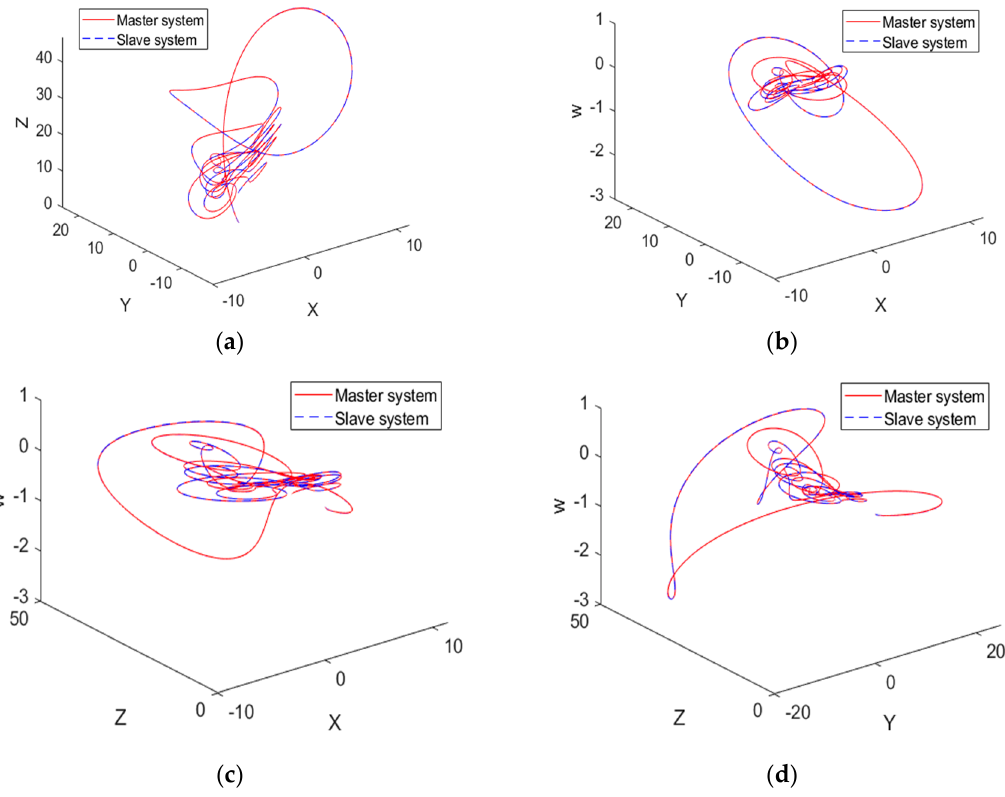
Figure 22. Synchronization of 4D Lorenz–Stenflo chaotic system using the SRIT2PC for Case 4 ( a ) x-y-z space, ( b ) x-y-w space, ( c ) x-z-w space, ( d ) y-z-w space.